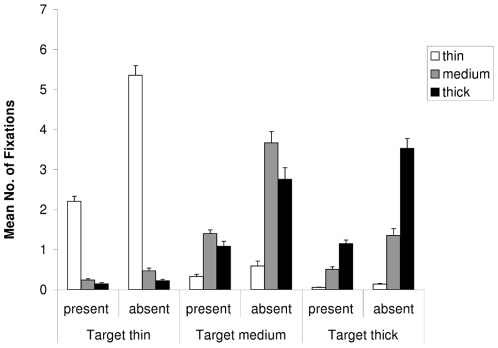
Results: Mean Number of Distractor Fixations.The mean number of fixations on each distractor type during visual search for a thin, medium or thick target, respectively. Error bars depict +1 SEM.